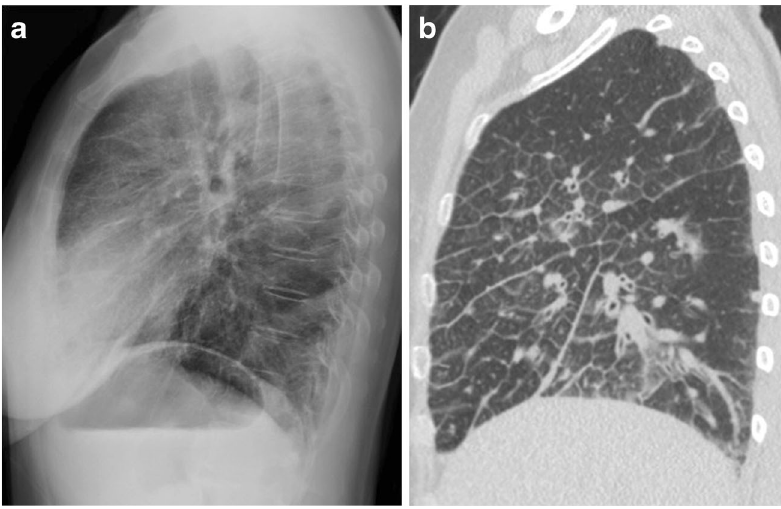
Fig. 8 62-year-old woman with metastatic lung adenocarcinoma and lymphangitic carcinomatosis. Interlobular septal thickening is clearly seen in the retrosternal clear space on the lateral radiograph (a). A corresponding sagittal CTslice (b) is also shown